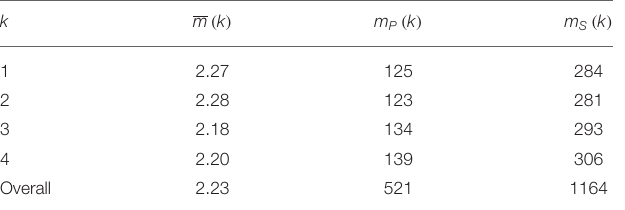
TABLE 1 | Subjects and images of four